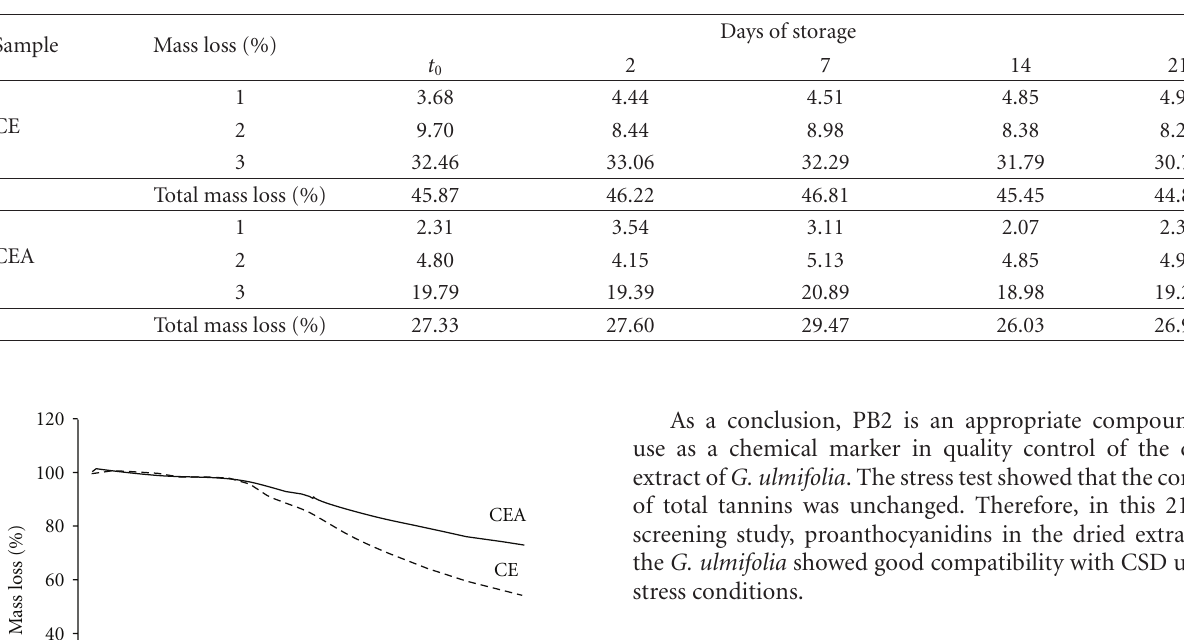
Table 2: Thermogravimetry parameters of the crude extract (CE) and the crude extract + colloidal silicon dioxide (CEA) of Guazuma ulmifolia .